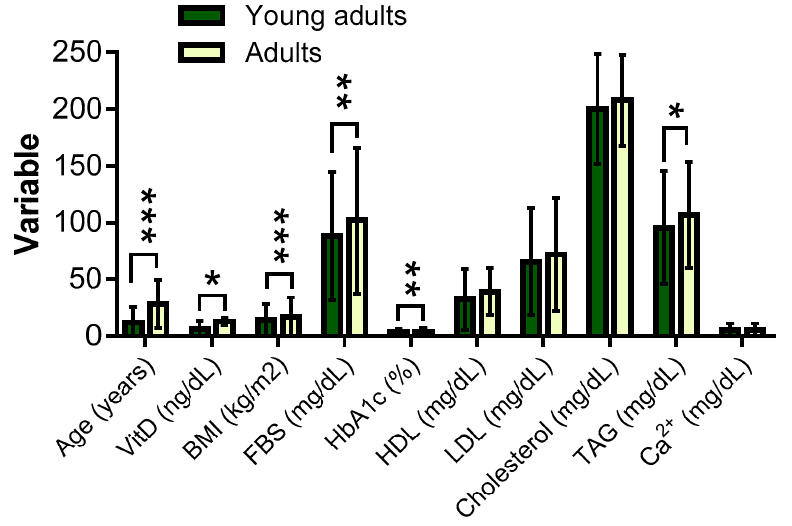
Figure 2. Mean age, VitD status and other health indicators in Libyan young adults and adults. N = number; % = percentage within population; BMI = body mass index; FBS = fasting blood sugar; HbA1c = glycosylated hemoglobin; HDL = high-density lipoproteins; LDL = low-density lipoproteins; TAG = triglycerides; Ca 2+ =calcium; VitD = vitamin D. ( * ) indicates p < 0.05 , ( ** ) indicates p < 0.01, and ( *** ) indicates p < 0.001.